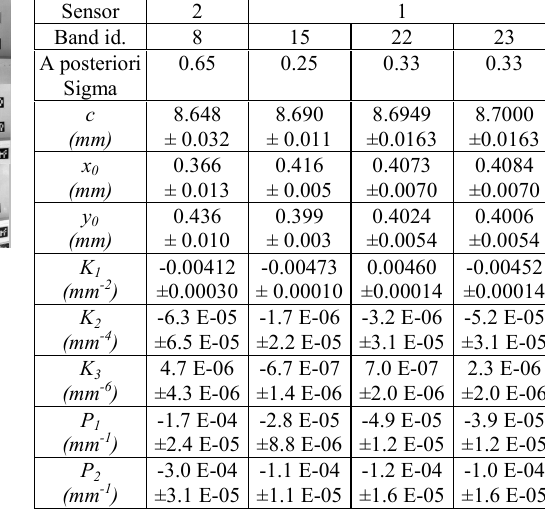
Table 5. Estimated IOP and a posteriori sigma for image bands of sensors 1 and 2.